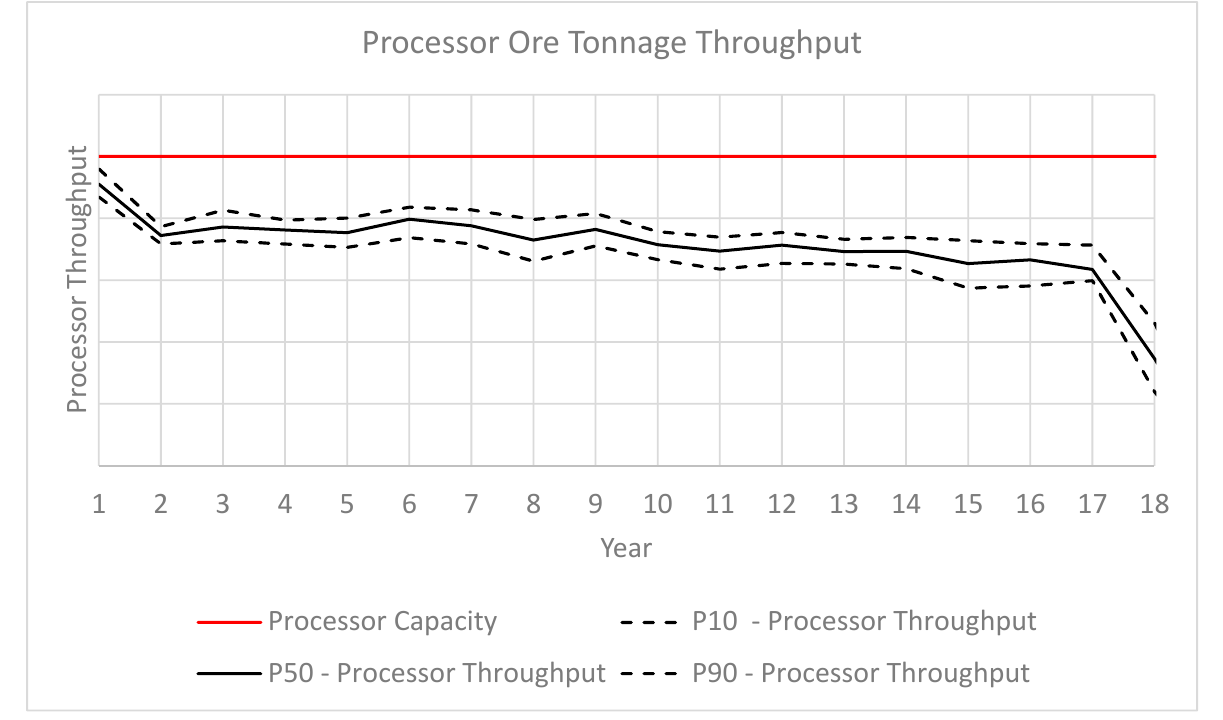
Figure 10. Semi-autogenous grinder (SAG) mill utilization.